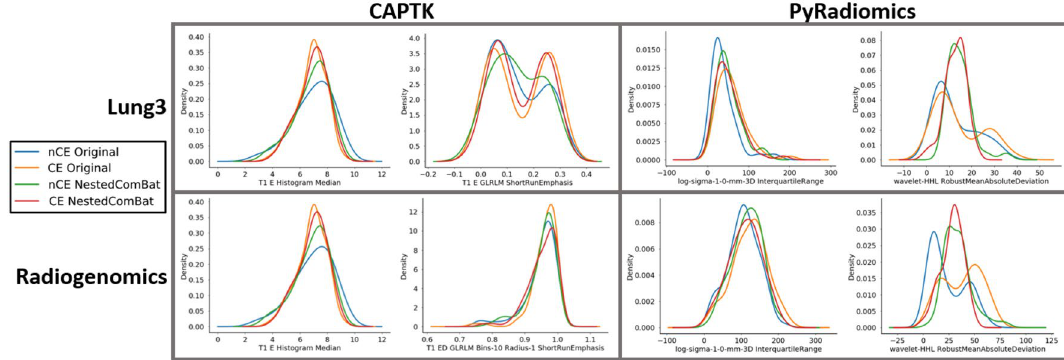
Figure 1. Representative kernel density plots for the original features and after applying Nested ComBat. Kernel density plots represent Nested ComBat results split on contrast enhancement, where nCE indicates no enhancement and CE indicates enhancement. Harmonization should result in more similar feature distributions. Within each combination of feature extraction package and software, the plot on the left illustrates the effect of Nested ComBat on a Gaussian distribution, while the plot on the right illustrates the effect of Nested ComBat on a bimodal